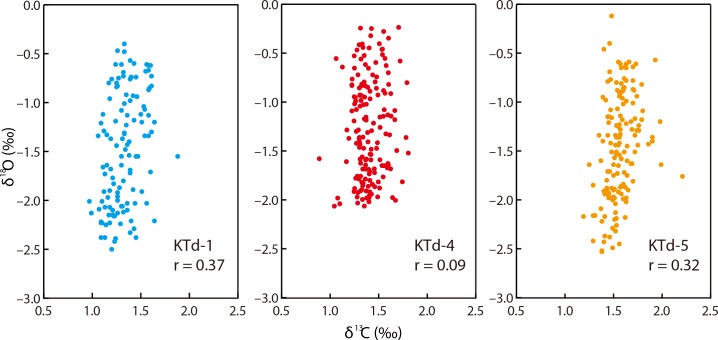
Cross-plots of δ13Cshell versus δ18Oshell for the studied Tridacna derasa shells.The δ13Cshell and δ18Oshell values show weak or no significant correlations.